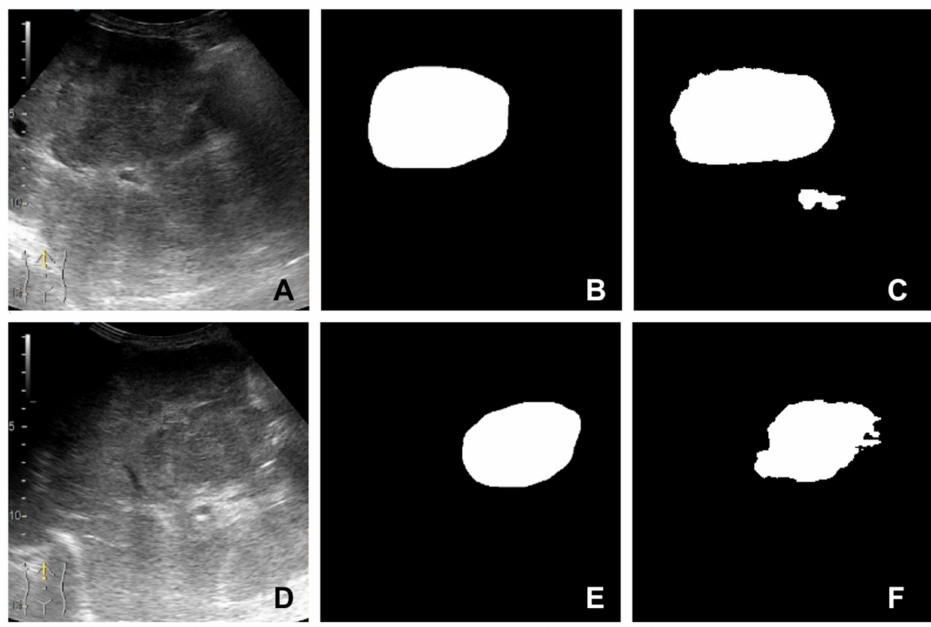
Figure 2. Samples extracted from the image segmentation dataset: ( A , D ) B-mode frame cropped from the video investigation; ( B , E ) mask (label) created by the senior gastroenterologist; ( C , F ) the mask predicted by the segmentation model.